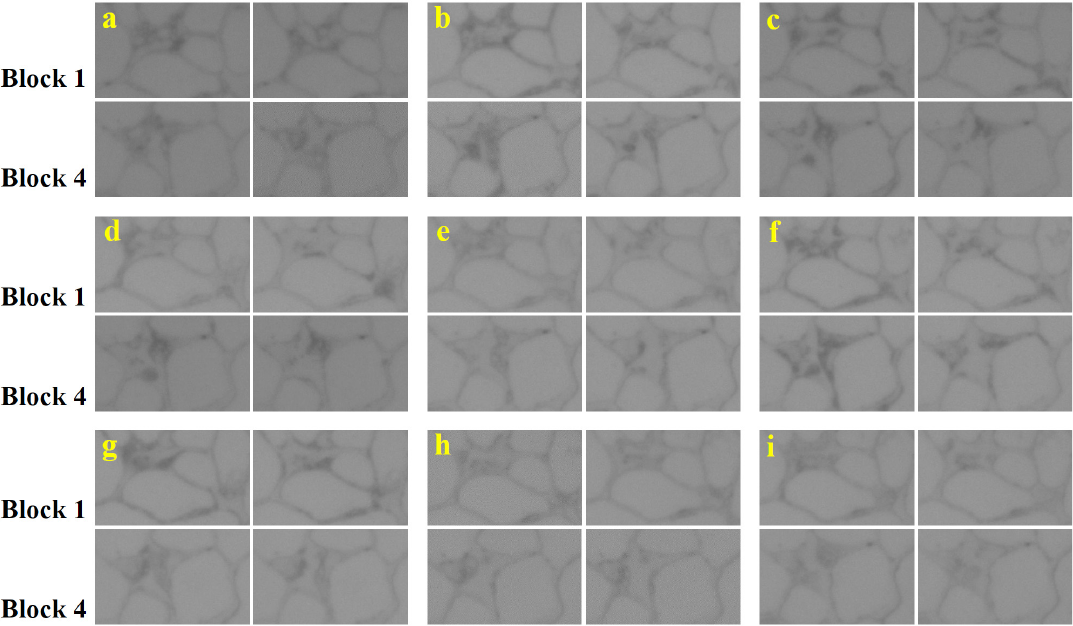
Figure 7. The oil/water distribution in Block 1 and 4 at 100th and 200th images (( a )—0 Hz; ( b )—1 Hz; and 0.005 mL/min; ( c )—1 Hz and 0.01 mL/min; ( d )—2 Hz and 0.005 mL/min; ( e )—2 Hz and 0.01 mL/min; ( f )—3 Hz and 0.005 mL/min; ( g )—3 Hz and 0.01 mL/min; ( h )—2 Hz and 0.005 mL/min; ( i )—2 Hz and 0.01 mL/min).